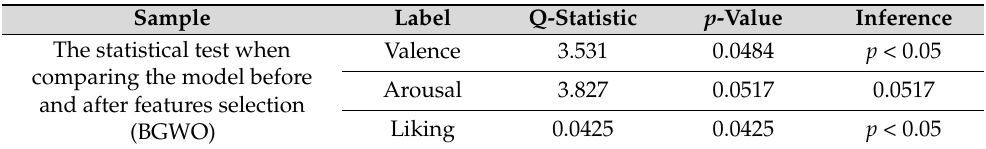
Table 7. Statistical test after feature selection.